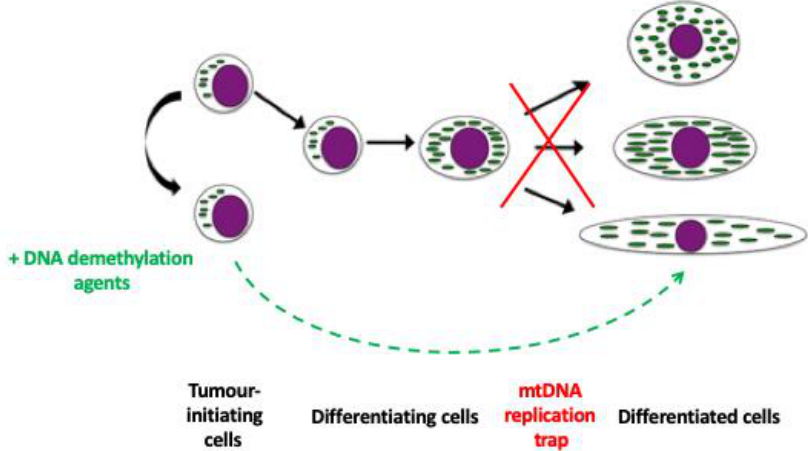
Figure 2. The mtDNA replication trap. Tumour-initiating cells are frequently unable to complete differentiation. Consequently, they are trapped between a naïve and a differentiated state. However, some DNA demethylation agents act by resetting the epigenome and mtDNA copy number in these cells, which then allows for the cell to differentiate into its mature phenotype with both the nuclear and mitochondrial genomes acting in synchrony.